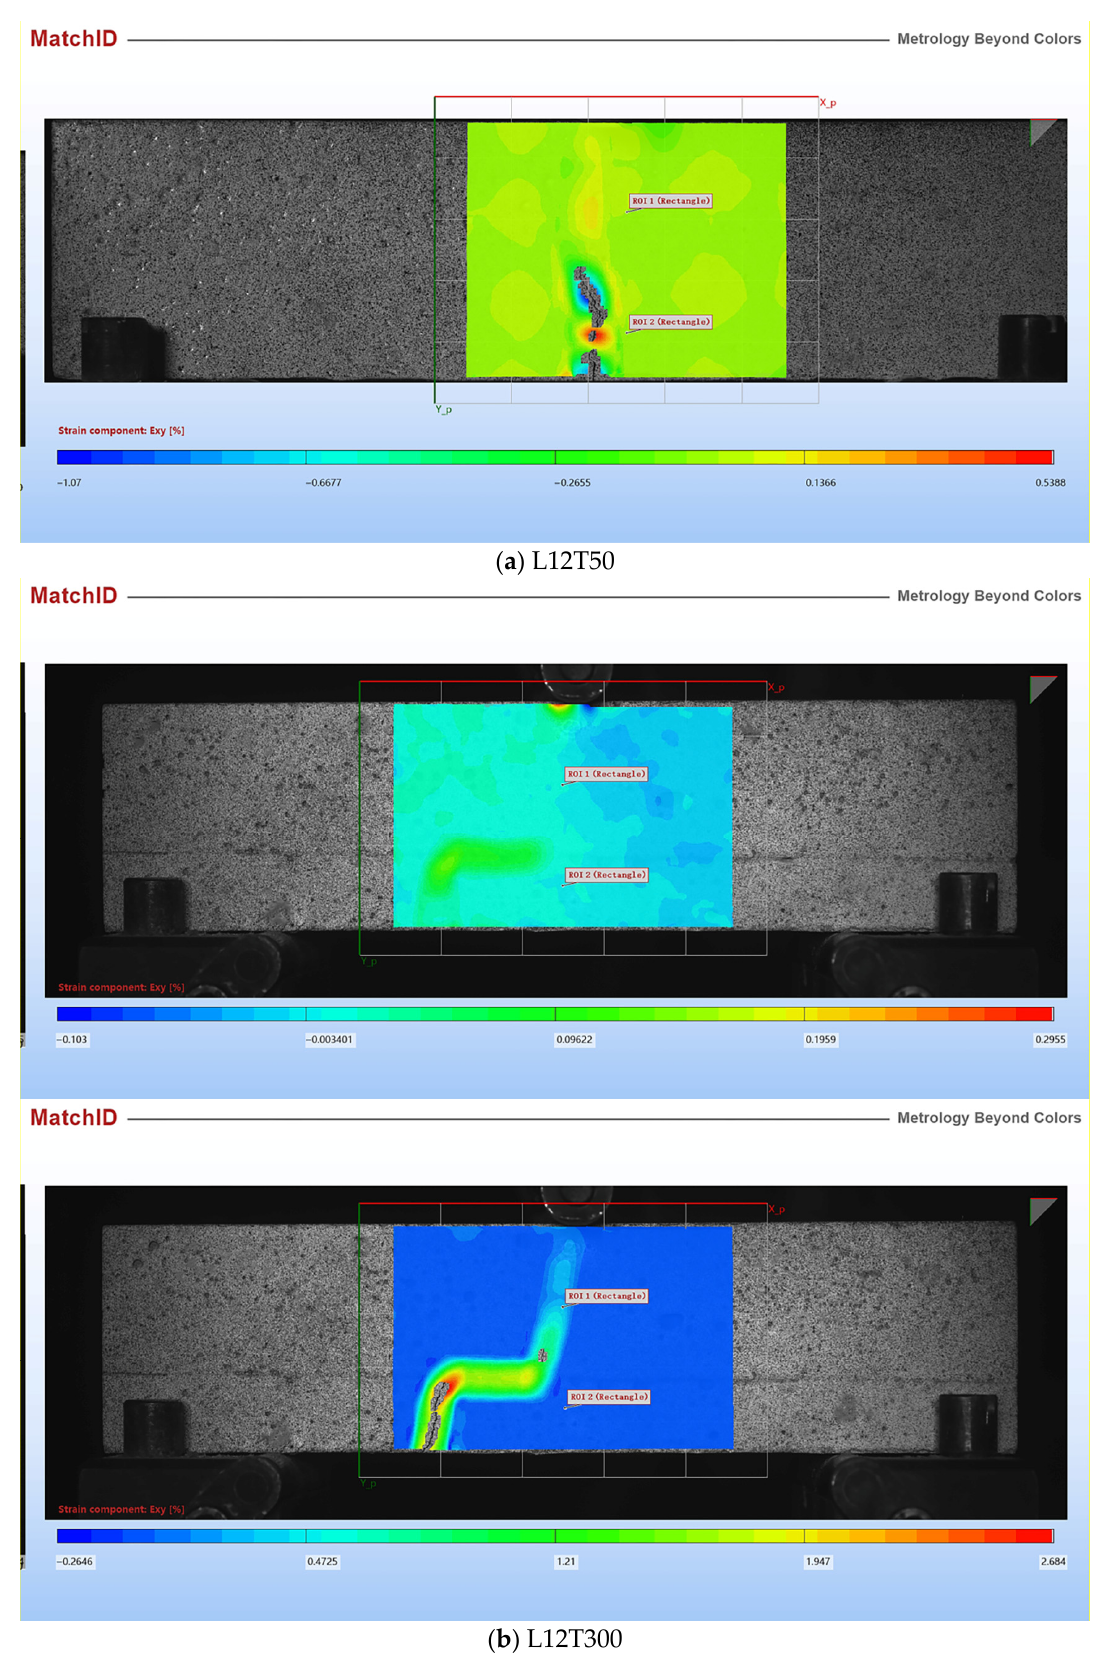
Figure 10. Shear strain distribution of sample L12T50 ( a ) and L12T300 ( b ).